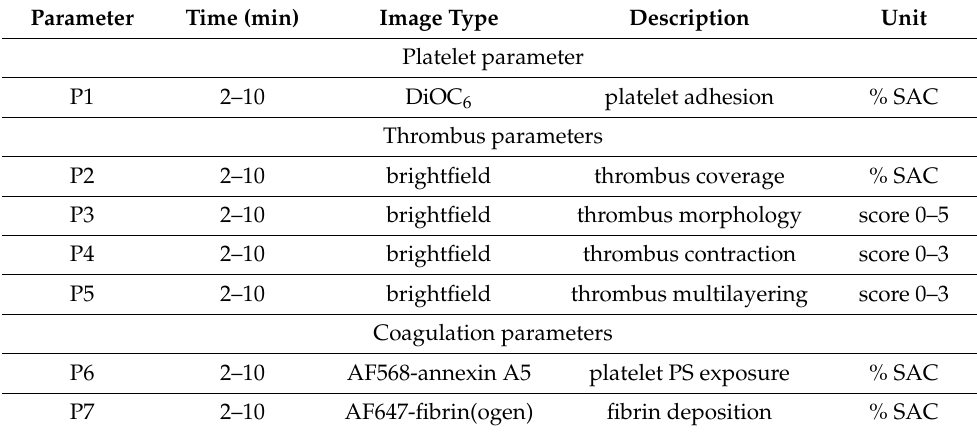
Table 1. Parameters and microscopic image sources of thrombus formation. Seven parameters were obtained per whole-blood flow run at time points 2, 4, 6, 8, and 10 min. These were categorized into platelet (P1), thrombus (P2–5), and coagulation-related parameters (P6–7). Abbreviations: PS, phosphatidylserine; SAC, surface area